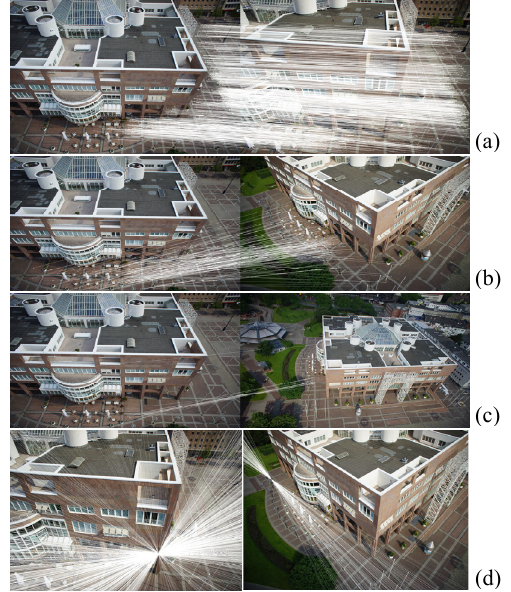
Figure 5. Results of the matching procedure; (a)-(c) inliers between images, (d) epipolar lines The principal distance that was computed using the manually measured vertical and horizontal line segments differs approximately 1.7% from the one calculated via the self- calibrating bundle block adjustment and the estimated principal